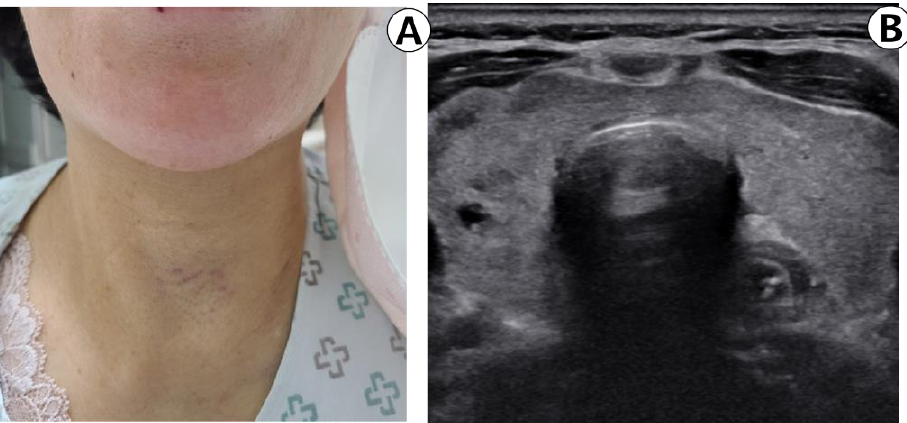
Figure 5. ( A ) Photograph of the patient on discharge day showing improved swelling of the anterior neck. ( B ) Sonographic view of improved thyroid hematoma on discharge day .